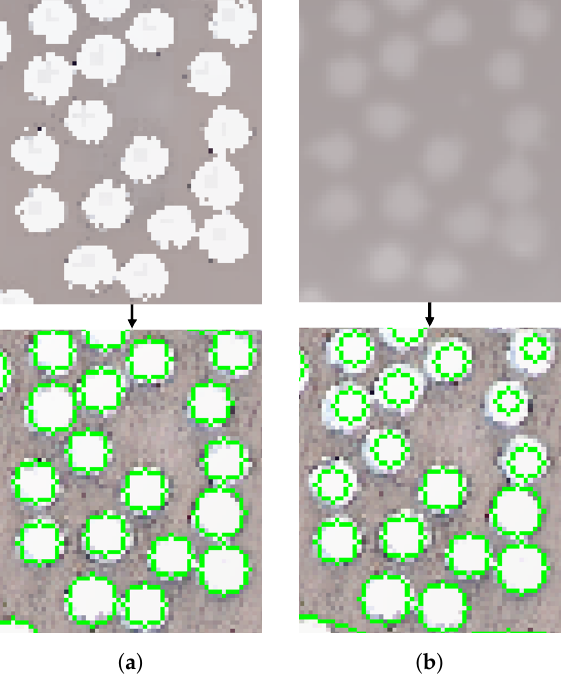
Figure 16. Optimal ( a ), Sp = 20 & Sr = 50 versus extreme ( b ), Sp = 100 & Sr = 100 mean shift filtering results.